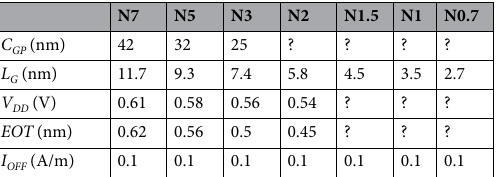
Table 1. III–V ITRS 2013 HP Roadmap extended for gate lengths below 5 nm. Supply voltage is denoted by